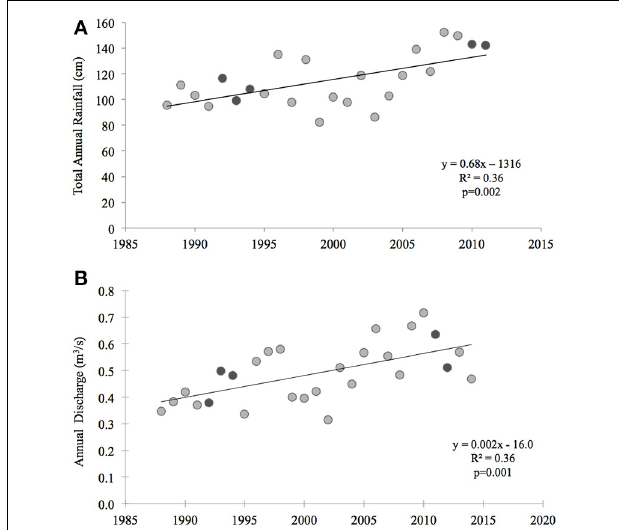
FIGURE 7 | Total annual rainfall and freshwater discharge in the Waquoit Bay watershed. (A) Annual rainfall (centimeters (cm)) was measured from 1988 to 2012 at the Department of Conservation and Recreation’s rainfall station (FAL904) in Falmouth, MA (data can